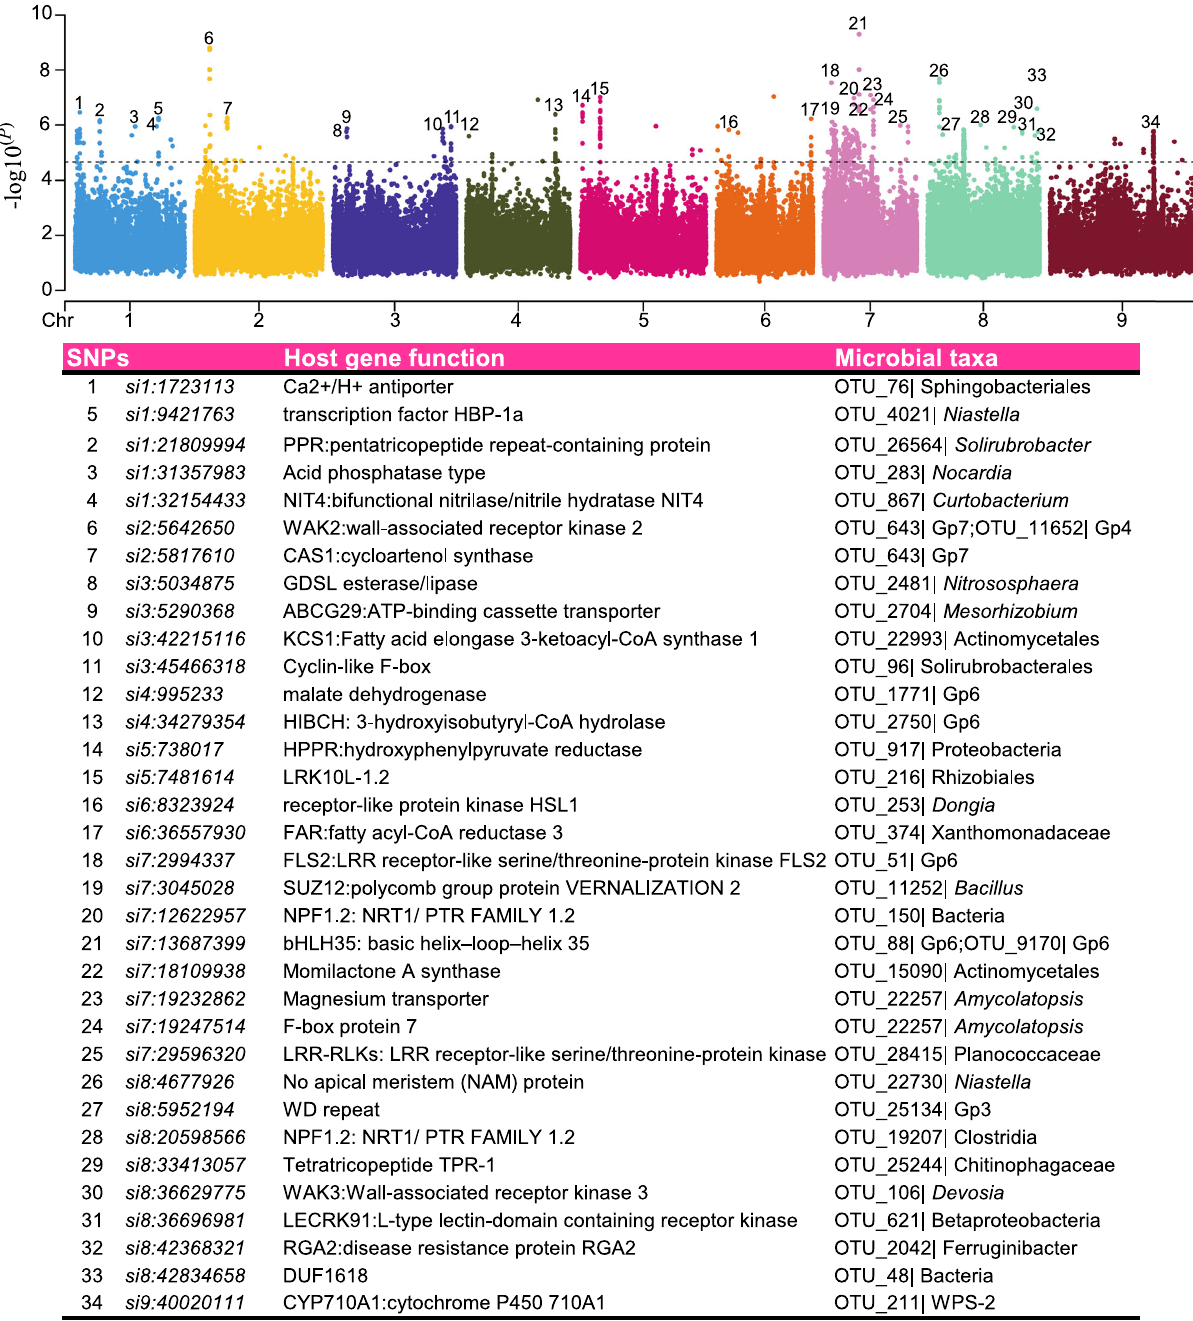
between the host genes and microbial species are given in the table below. All of these associations of SNP loci and microbial OTUs were signi fi cantly lesser than 2.01e −